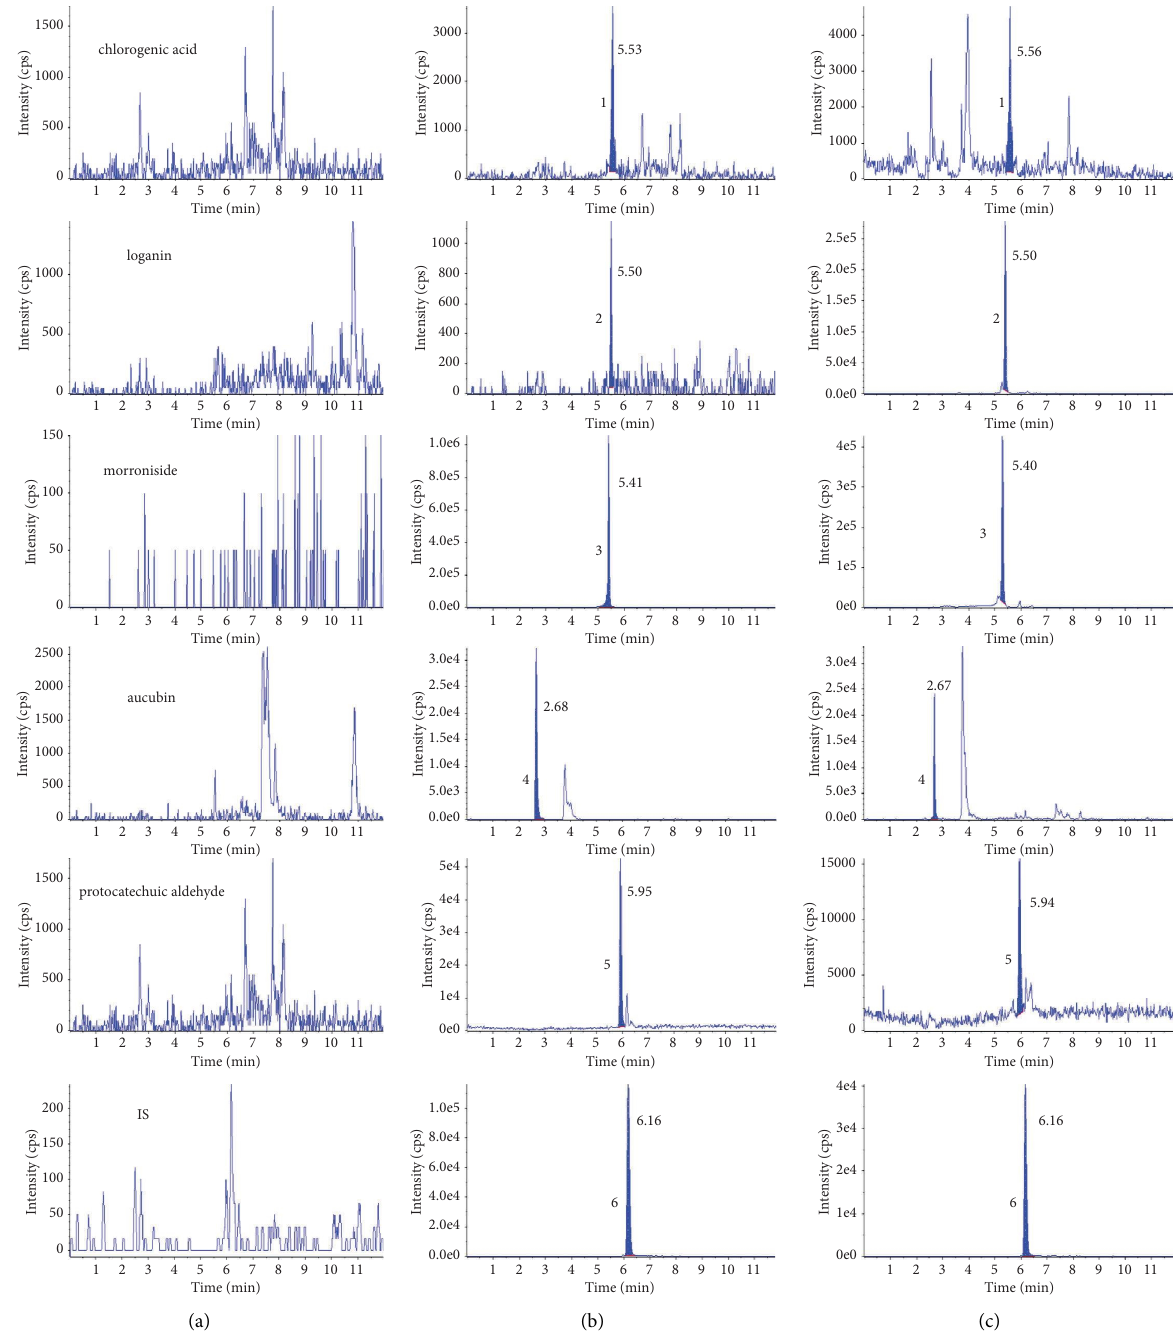
Figure 4: Multiple reaction monitoring chromatograms of each analyte and IS: (a) blank plasma; (b) blank plasma spiked with analytes and IS; (c) plasma sample obtained 30 min after oral administration of Zuogui Pill. Table 3: Calibration curves, correlation coefcients, linear ranges, and LLOQs of 5 compounds.